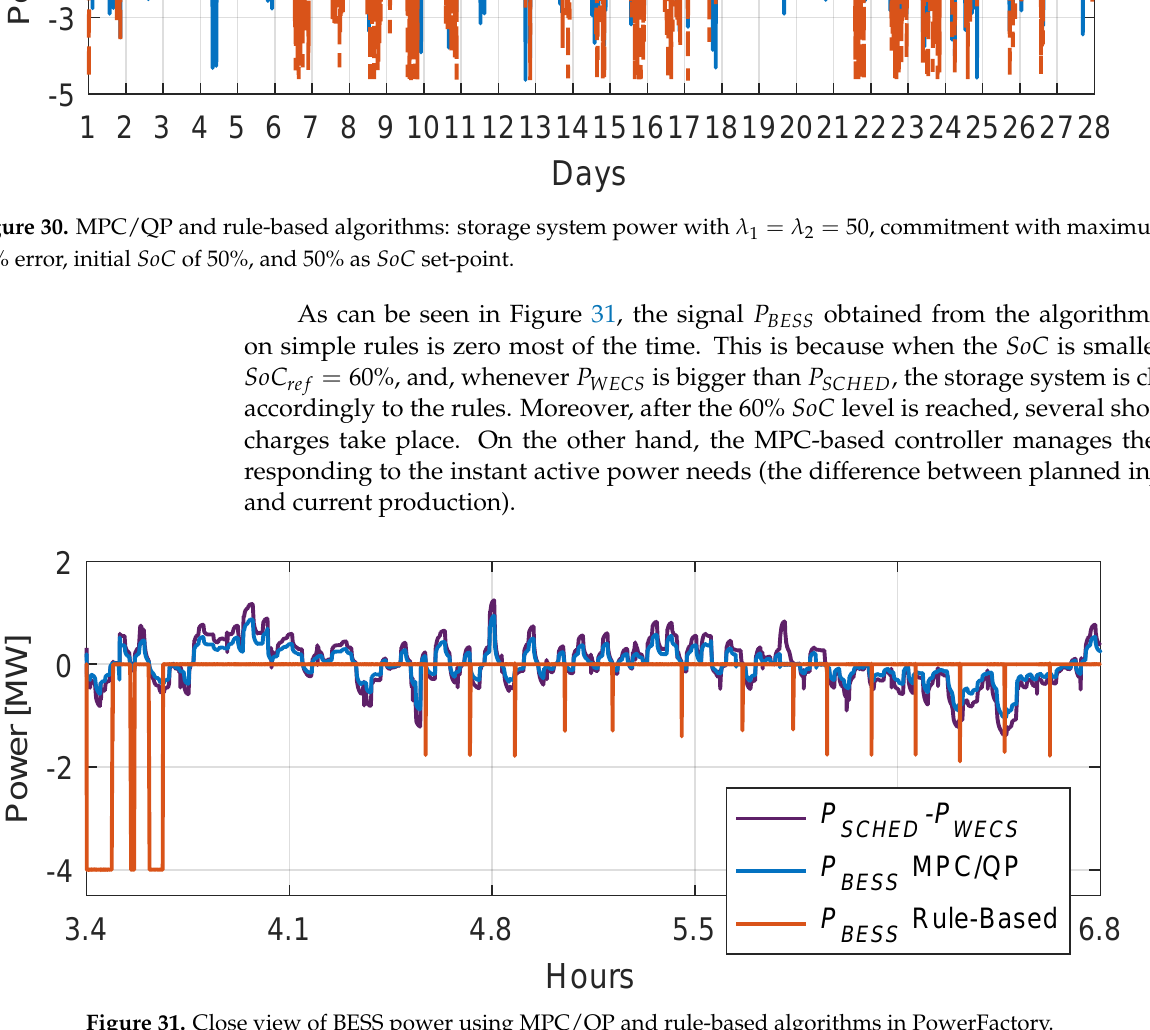
Figure 31. Close view of BESS power using MPC/QP and rule-based algorithms in